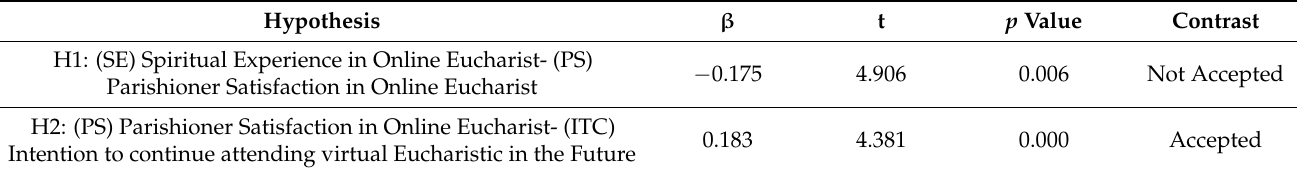
Table 6. Structural model